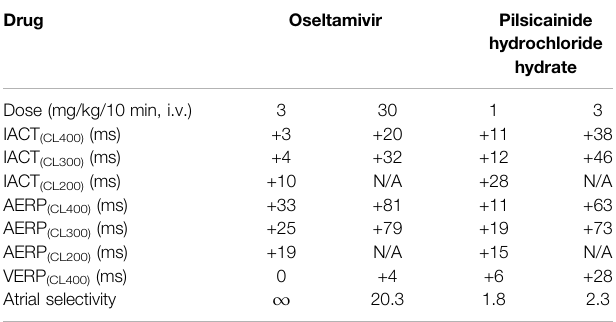
Each value represents the change from its corresponding pre-drug control value at 10 min after the start of intravenous administration. Atrial selectivity was calculated as